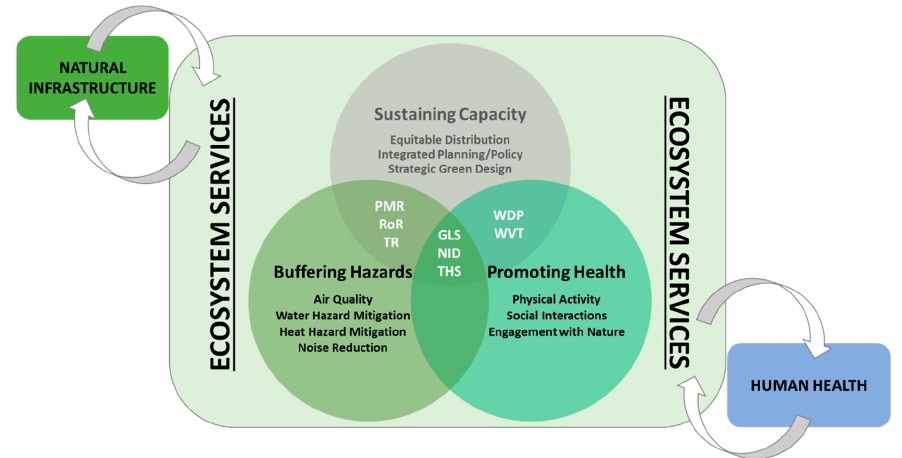
Figure 1. The conceptual framework for Community Ecohealth Index (CEHI) includes overlapping domains for bu ff ering hazards, promoting health, and sustaining capacity. Multiple ecohealth indicators are associated with each domain, and metrics selected for CEHI can be linked to one or more of these indicators and domains. Metrics include: % PM10 removed annually by tree cover (PMR), % annual runo ff reduction due to tree cover (RoR), average summer daytime temperature reduction in ◦ C due to tree cover (TR), % greenery along low-speed (walkable) streets (GLS), natural to impervious ratio X populationdensityinacres(NID),%high-speedstreetsborderedby > 25%treebu ff er(THS),%residential population within 500-m walking distance of a park entrance (WDP), inverse of % residential population with < 5% views of trees (WVT). For more information, see Table